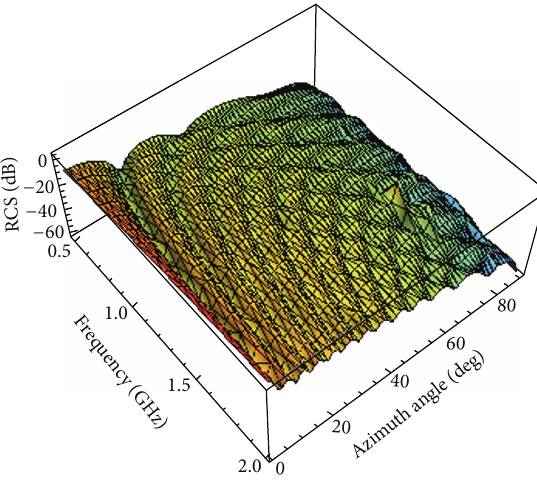
Figure 17: Absolute errors for different 𝑘 and 𝜑 = 60 ∘ .